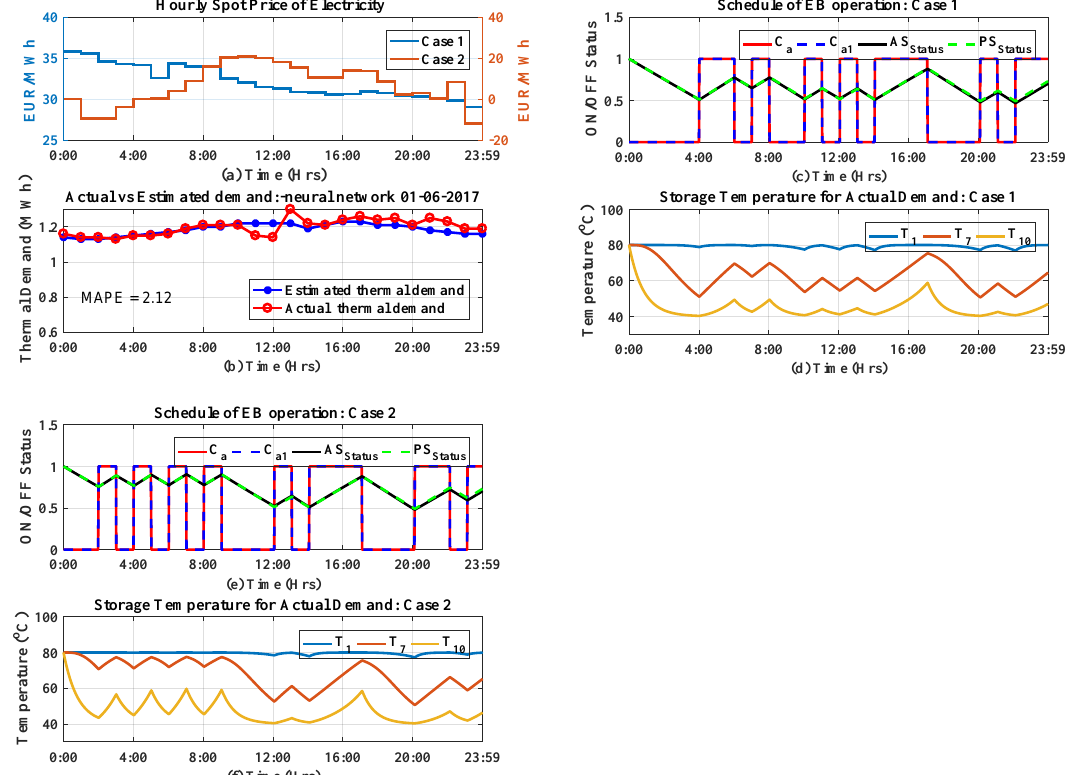
Figure 16. ( a ) Hourly spot prices of electricity in Denmark region DK1 case 1: 6 January 2017 and case 2: 24 December 2016 ( b ) Actual and estimated thermal demand on 6 January 2017 ( c ) estimated EB schedule based on estimated demand ( C a 1 ), estimated EB storage status ( PS status ), and actual schedule of EB based on actual demand ( C a ), and actual EB storage status ( AS status ) (case 1). ( d ) Storage temperature of various layers for actual demand and schedule (case 1). ( e ) estimated EB schedule based on estimated demand ( C a 1 ), estimated EB storage status ( PS status ), and actual schedule of EB based on actual demand ( C a ), and actual EB storage status ( AS status ) (case 2). ( f ) Storage temperature of various layers for actual demand and schedule (case 2).